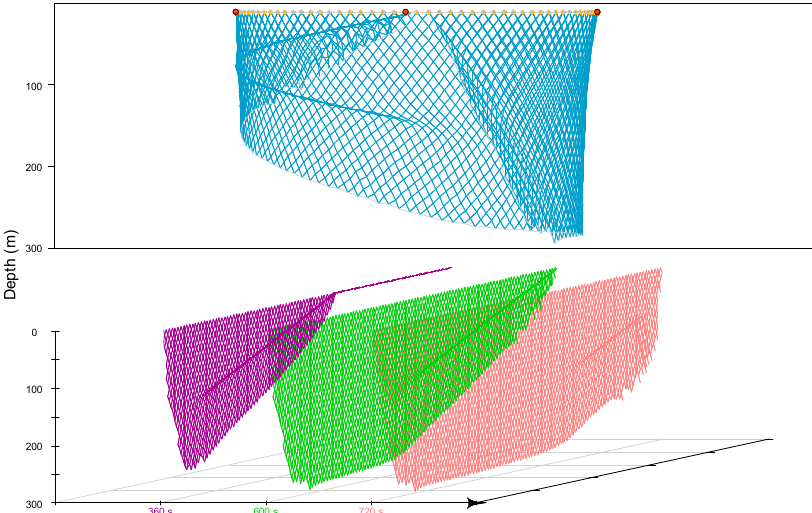
Figure 4. Front view of the seine net in stationary water, showing the instant sinking depth at the end of shooting (top), and the horizontally unfolded plane for three typical points in time after shooting started: 300 s (during shooting, purple), 600 s (end of shooting, green), and 720 s (during pursing, orange) (bottom).